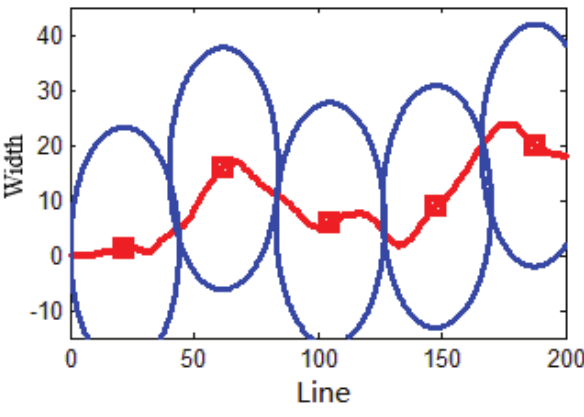
Figure 17: Case 3: The optimal complicated tunnels by ECO algorithm (R = 22)